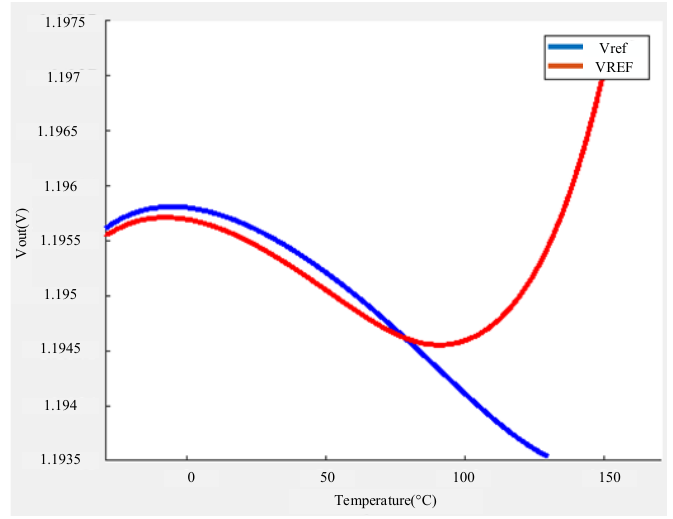
Figure 7. The temperature curve for first-second and second-order BGR. The design of the circuit should be analyzed at various process corners, various operating voltages, and various ambient temperatures; these are the bases for determining the yield. The simulation of process corners is performed for the proposed BGR circuit; with SS, TT, and FF referring to the lower left direction of the corner, the middle of the center, and the upper right direction of the corner, respectively [21]. Trimming resistor R7 can be used to correct the deviations. The simulation of the graph is shown in Figure 8.